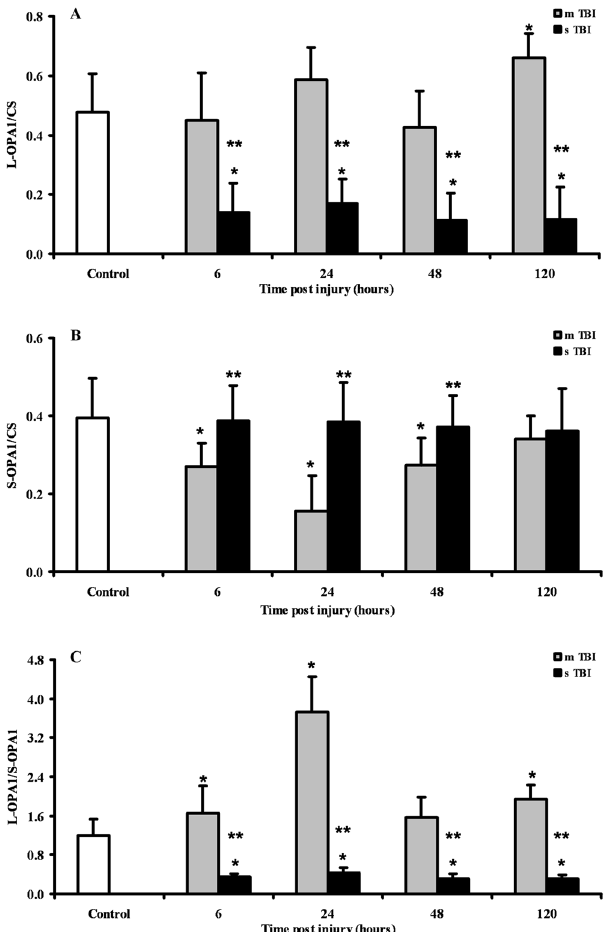
Figure 8. Semi-quantitative determination of the proteolytic products of OPA1 (L-OPA1 and S-OPA1) in brain tissue homogenates of rats receiving TBI of graded severity (mTBI and sTBI) at different times post-impact. The L-OPA1/S-OPA1 ratio is also reported. Values are the mean of 6 animals. Standard deviations are represented by vertical bars. Protein expressions were calculated relatively to CS (as a mitochondrial mass indicator). * Significantly different from controls, p < 0.05. ** Significantly different from the corresponding time of mTBI rats, p <